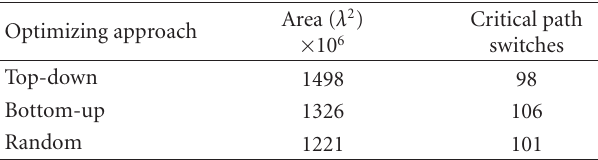
Table 3: Area and performance comparison between various optimizing approaches (21 benchmark